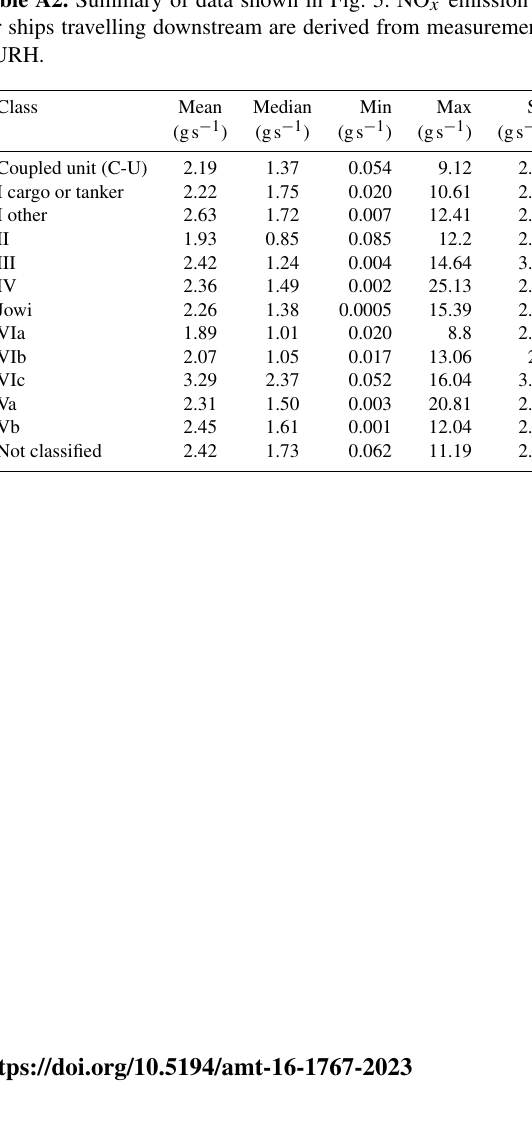
Table B2. Summary of data shown in Fig. 11. NO x emission rates for ships leaving NERH are